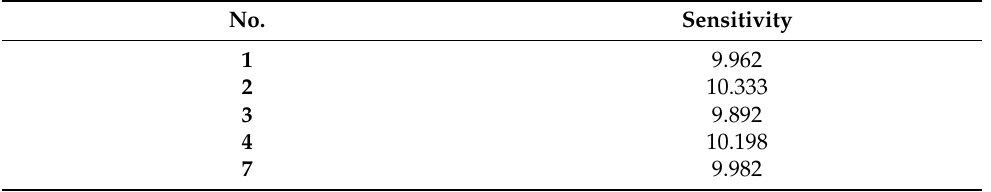
Table 4. Sensitivity of accelerometer (mV/ms − 2 ).